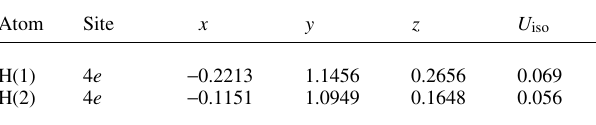
Table 2. Atomic coordinates and displacement parameters (in Å 2 ) .